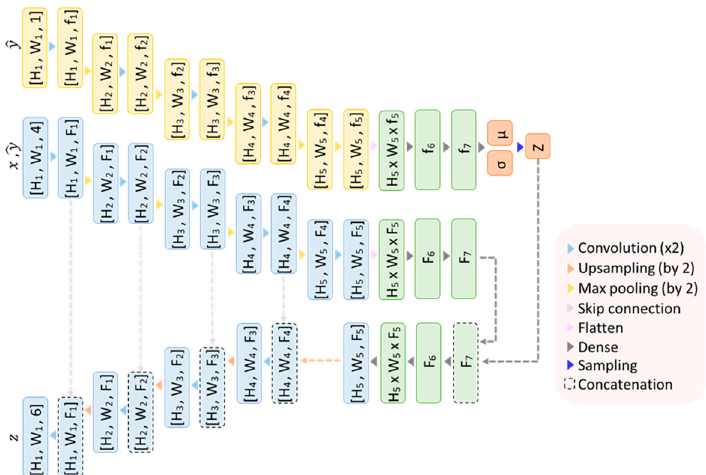
Figure A2. The architecture of Network 1, which is based on conditional variational U-Net. The input dimension of material properties (x) includes Young’s modulus, Poisson’s ratio, permeability, and stem cell concentration on the Nth day. The input dimension of occlusal forces ( ˆ y ) is (28, 64, 1). The output dimension of mechanical responses (z) is (128, 64, 6), including principal strain I, II, III, fluid flow in X and Y directions, and the stem cell concentration for the N + 1th